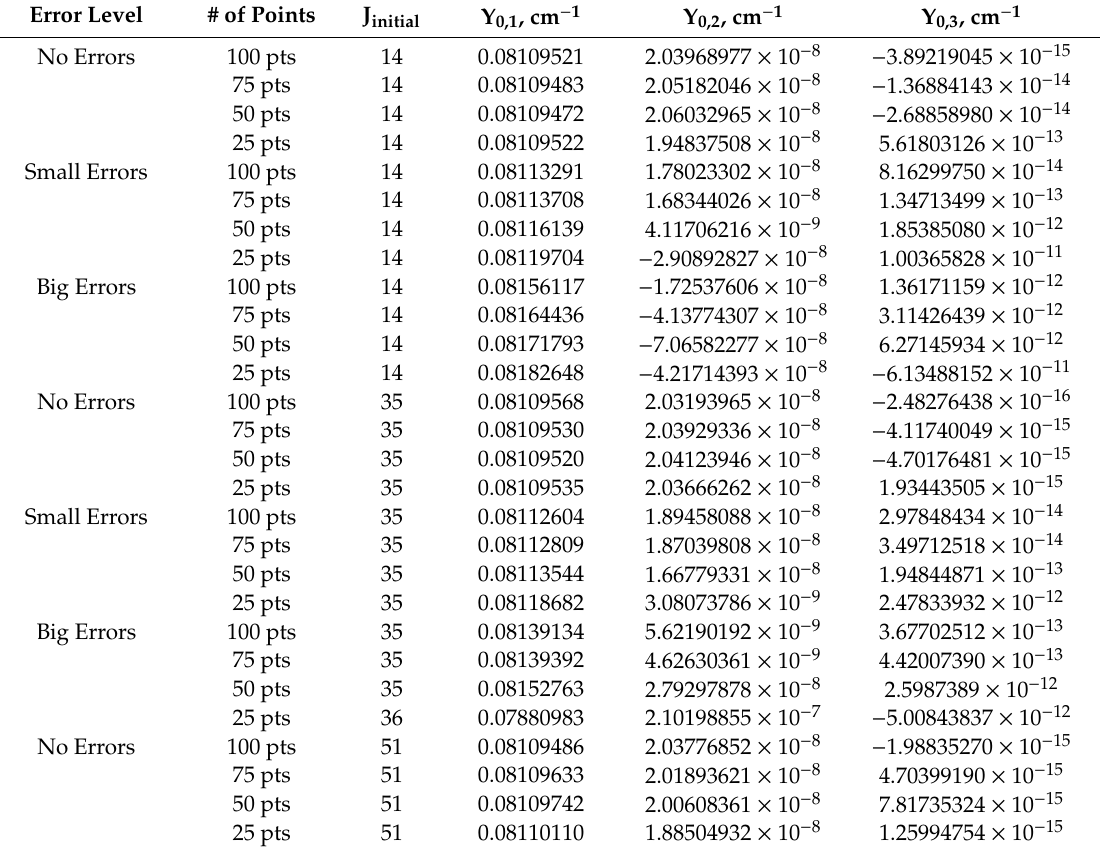
Table A1. Results from the initial test, where the number of points, the values of J, and the size of the errors were varied while calculating the corresponding values for J and the Dunham coe ffi cients. The starting J values were 14, 35, 51, and 81, and the actual Dunham coe ffi cients are shown at the bottom of the